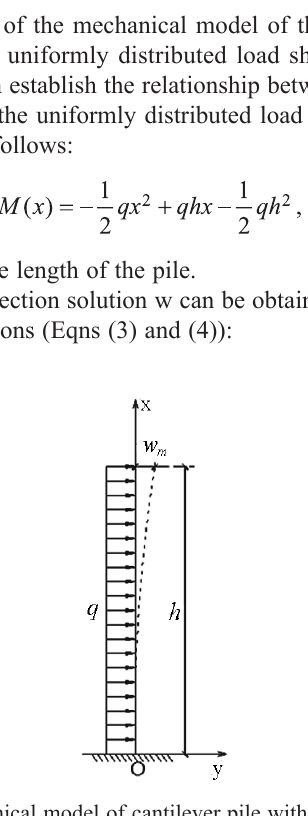
Fig. 1. Mechanical model of cantilever pile with uniformly distributed load